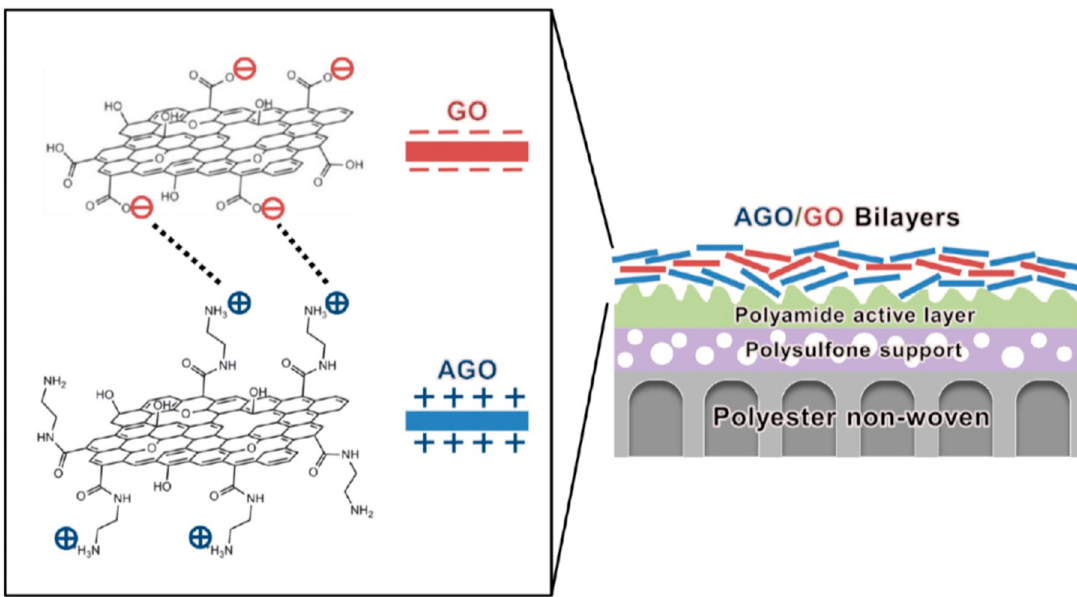
Figure 5. Layer-by-layer deposition of positively-charged GO and aminated-GO nanosheets on the membrane surface; reproduced with permission from Choi et al. [121], with copyright permission from © 2013, American Chemical Society.